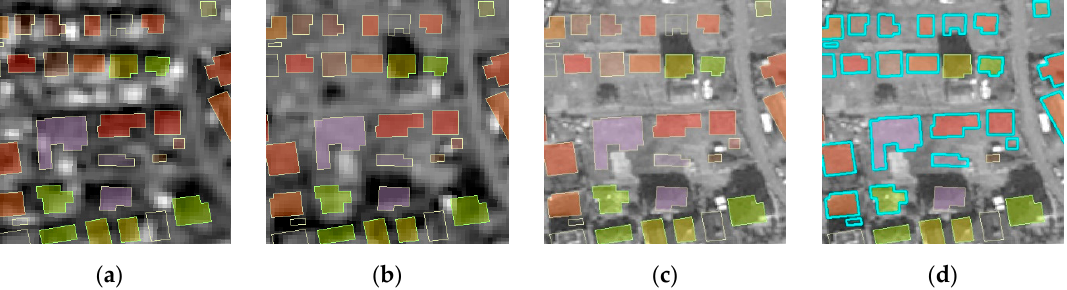
Figure 14. Visual interpretation of the indicator distribution map with transparent colors the same as Figure 12. ( a ) 20 March 2016 SPOT image; ( b ) 1 January 2017 SPOT image; and ( c ) 1 January 2017 Pleiades image. ( d ) Result of demolished building polygons by visual interpretation in the light blue outline.